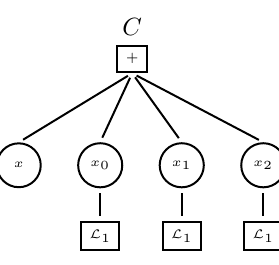
Figure 12: Masked encoding with d = 3